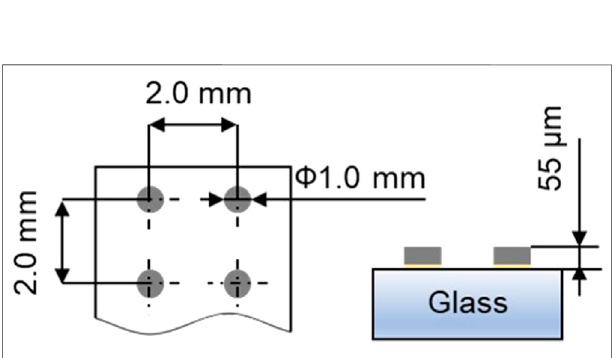
FIGURE 2 | Diagram of the mask produced in this